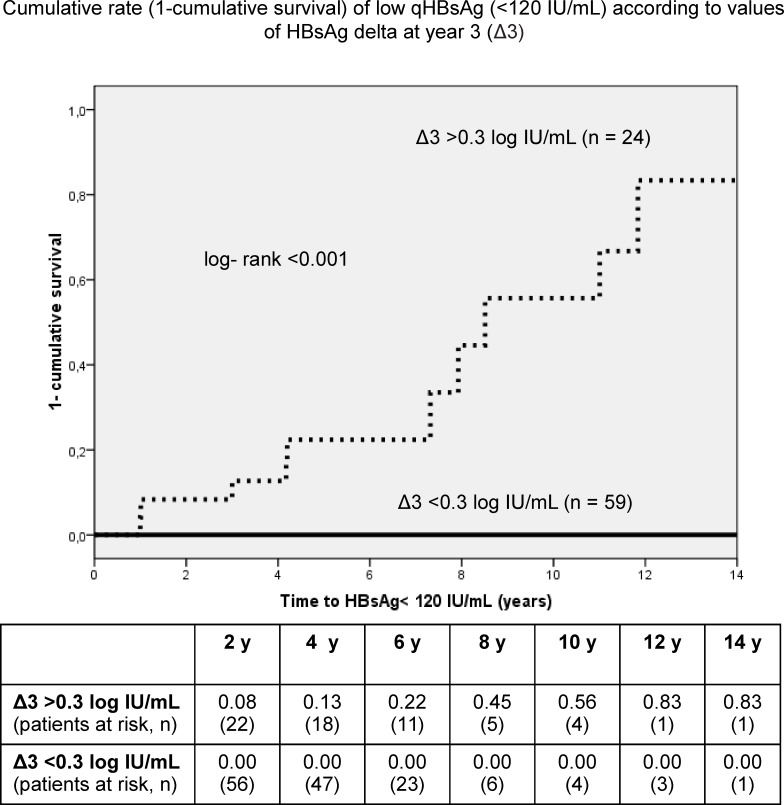
Cumulative probability (1-cumulative survival) of low qHBsAg according to values of HBsAg delta at the third year.The cumulative probability of patients with delta at year 3 (Δ3) >0.3 log IU/mL (n = 24) is depicted as a dotted line and those with Δ3 <0.3 log IU/mL (n = 59) as a solid line.